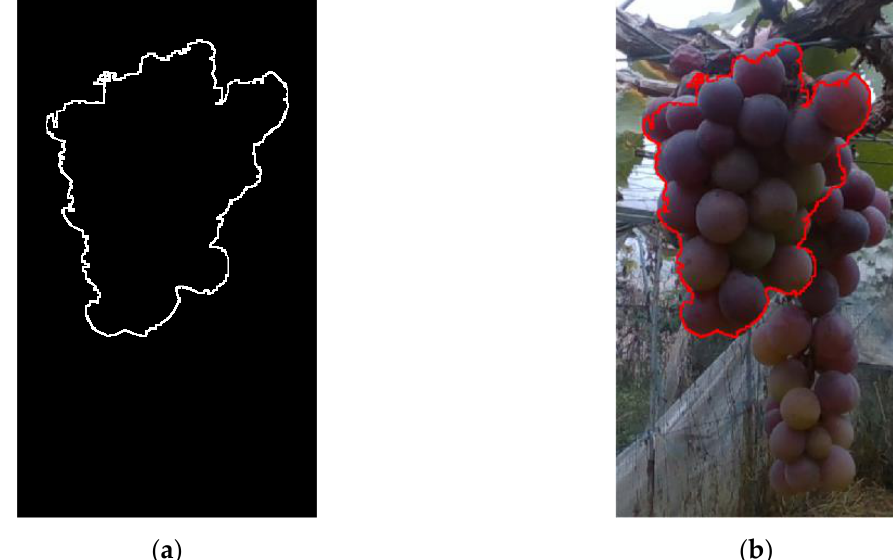
Figure 18. Instruments and equipment used for image capture. ( a ) RealSense D435, and ( b ) XSENS MTi-300.